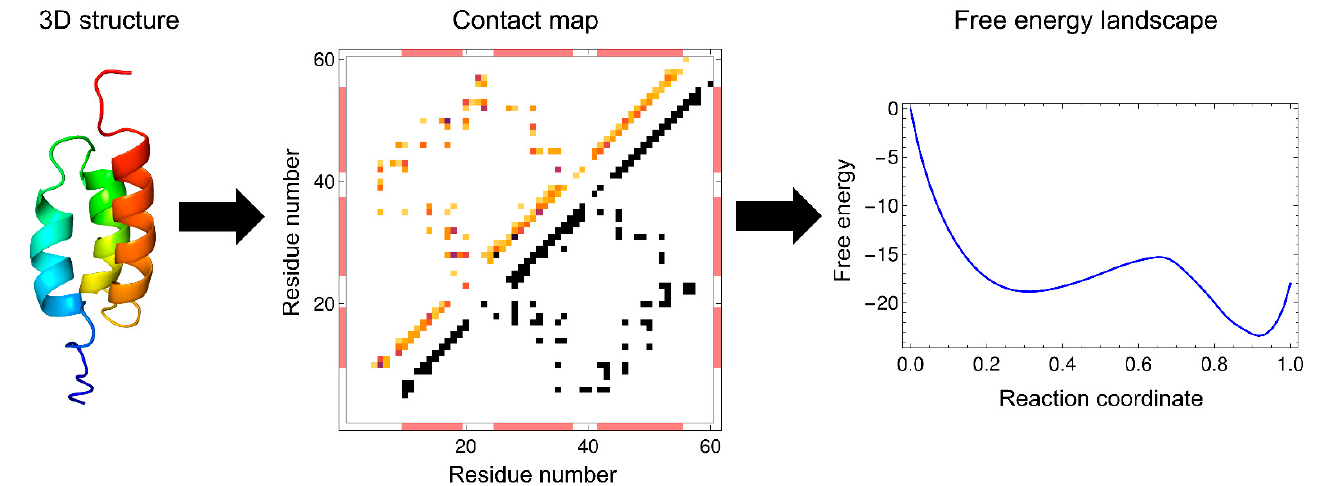
Figure 2. Basic procedure for calculating free energy with the WSME model. Based on the protein three-dimensional structure (left panel: the B domain of protein A (BdpA); PDB ID: 1BDD), a residue–residue contact map of the protein is calculated (middle panel). A pair of i - and j -th residues ( j > i + 2) is defined as being in contact when at least one of the distances between the atoms in the i - th residue and those in the j -th residue is less than 4 Å in the native state. The triangle in the lower right half (with black squares) is a binary contact map with a uniform contact energy, and the trian- gle in the upper left half (with colored squares) is a non-binary contact map weighted by the number of atoms in the native contacts. The partition function is calculated from the Hamiltonian based on the contact map, and the free energy is obtained as a function of the reaction coordinate (right panel). The one-dimensional free-energy landscape calculated using the uniform contact energy is shown. Adapted with permission from Ref. [26]. Copyright (2006) National Academy of Sciences, USA. 1 ,